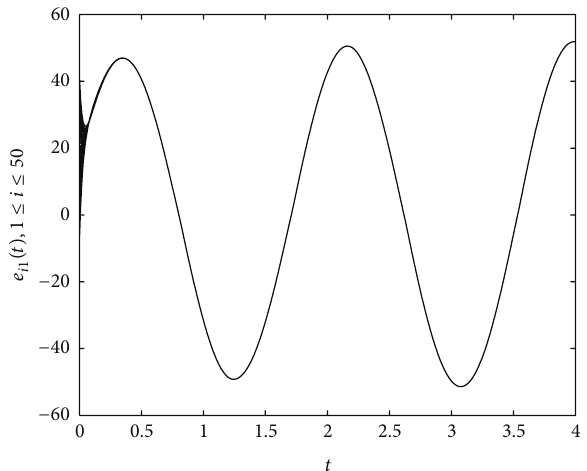
Figure 16: Synchronization errors 𝑒 𝑖 3 , 1 ≤ 𝑖 ≤ 50, with no control